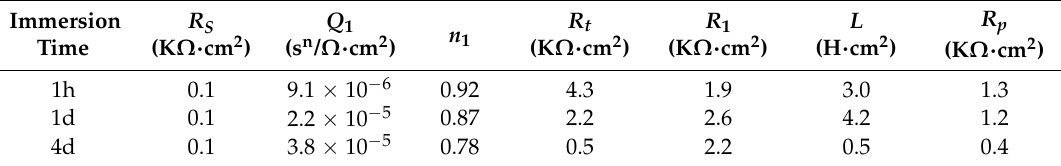
Table 3. Fitting parameters obtained from the EIS measurements of AZ31 immersed in Ringer’s solution (37 ◦ C) up to 4 days.